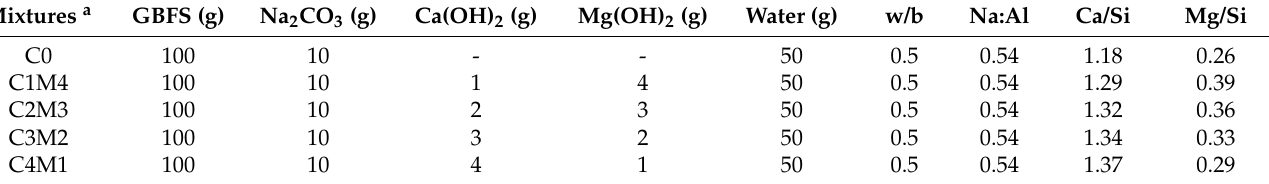
Figure 1. Schematic of the experimental procedure included in this study. Table 1. Mix proportions of one-part Na 2 CO 3 -activated binders.